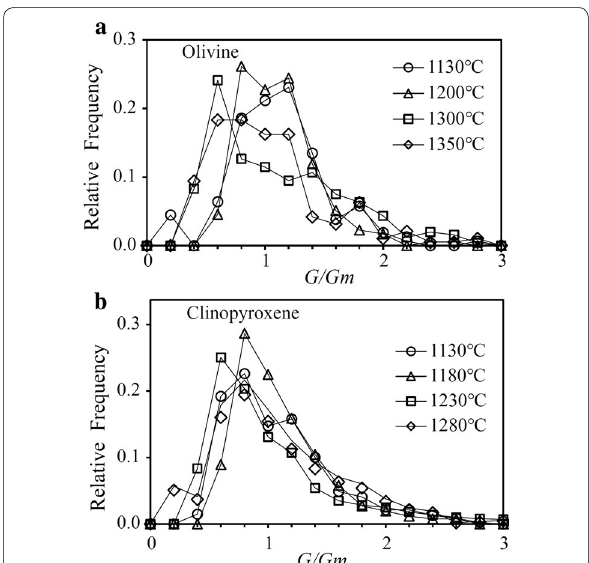
Fig. 2 Crystal size distribution (CSD) of a olivine and b clinopyroxene obtained from the samples sintered for 2 h at different